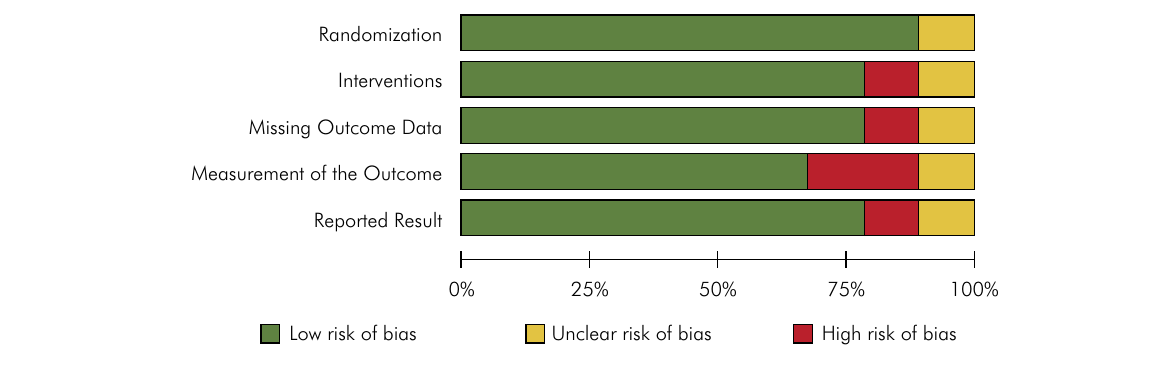
Figure 5. Risk of Bias graph of Randomized Clinical